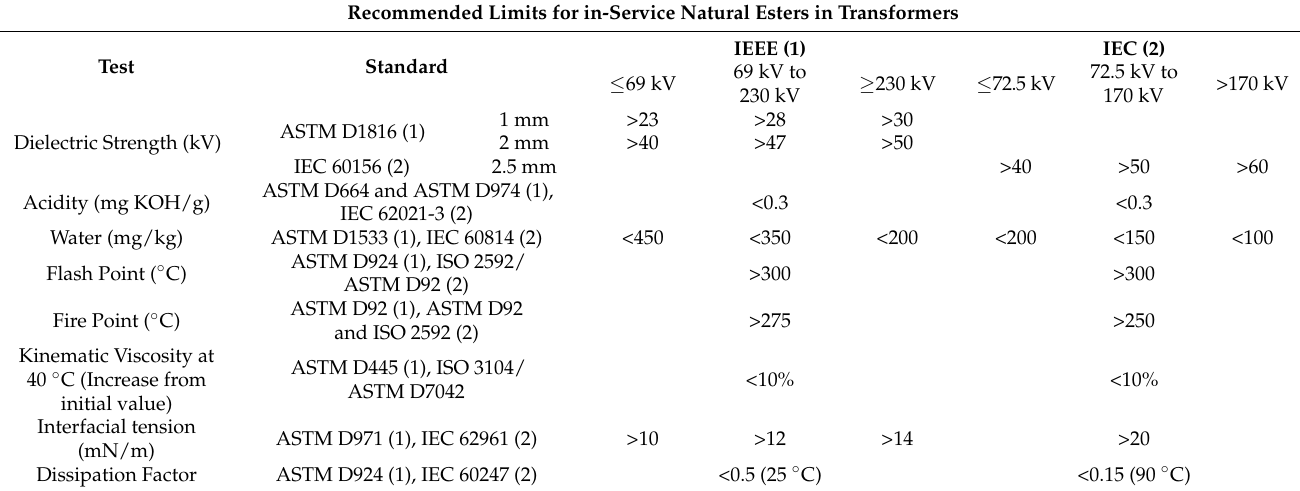
Table 3. Recommended limits for in-service natural esters in transformers